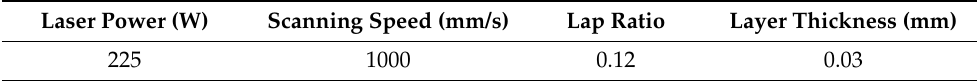
Table 1. Process parameter settings.